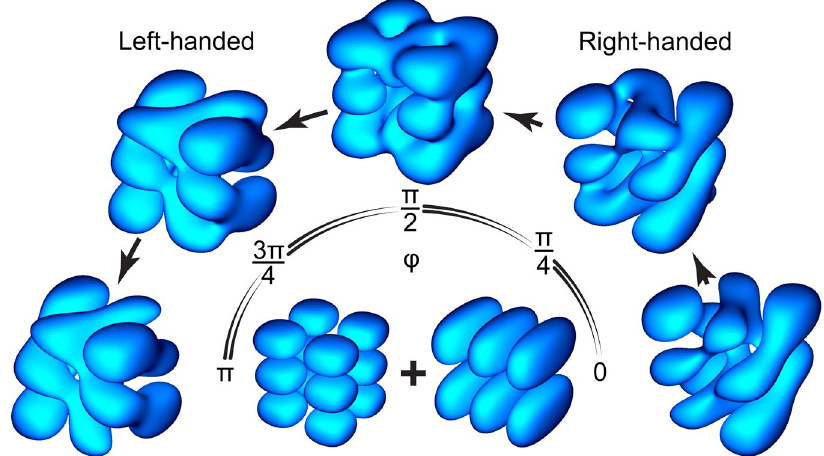
Figure 2. Transformation of probability density | 〈 r| f ( + ) 〉 | 2 with phase ϕ of interaction coupling a pair of resonant nanocuboid states |223 〉 and |312 〉